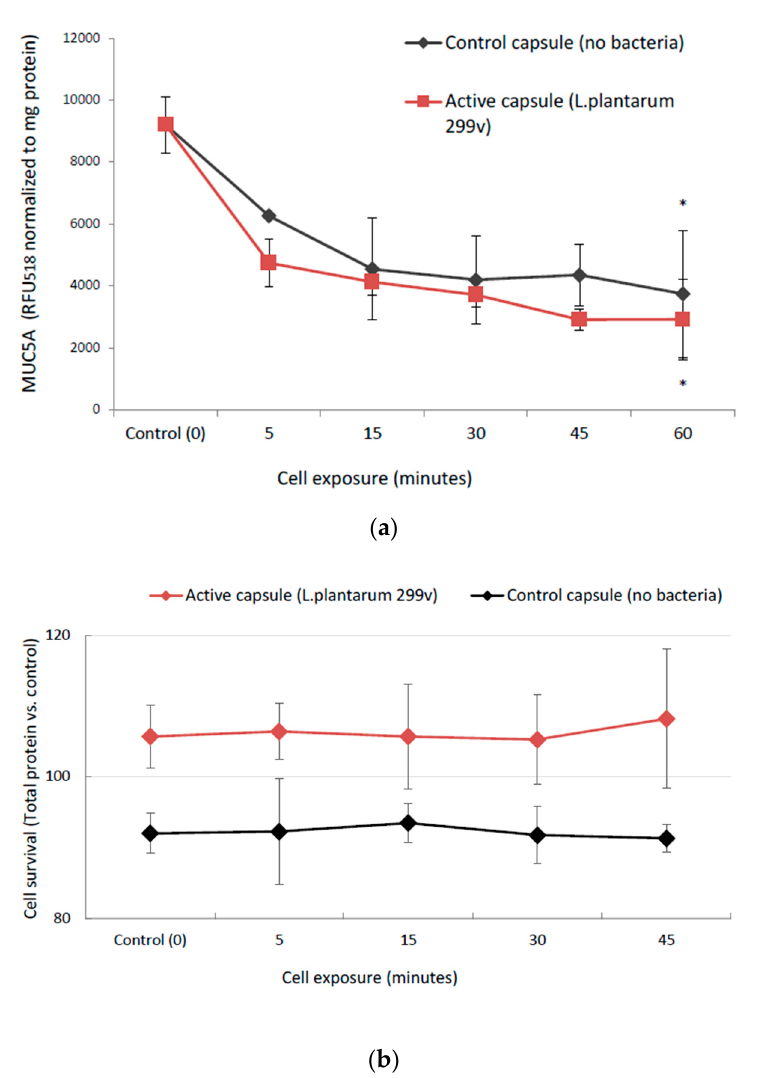
Figure 3. ( a ) Mucin production (MUC5AC) significantly decreased from baseline (control, no exposure to any capsules) in the presence of the capsules independent of L. plantarum 299v (from 0 to 60 min; p = 0.008 and p = 0.002 for control and active capsules, respectively). * indicates a significant difference from control; Data, shown as relative fluorescence units (RFU) normalized to total cell protein, are means ± SD, n = 3. ( b ) Total protein (proportional to cell number) shows that the decrease in mucus production is not caused by cell death.